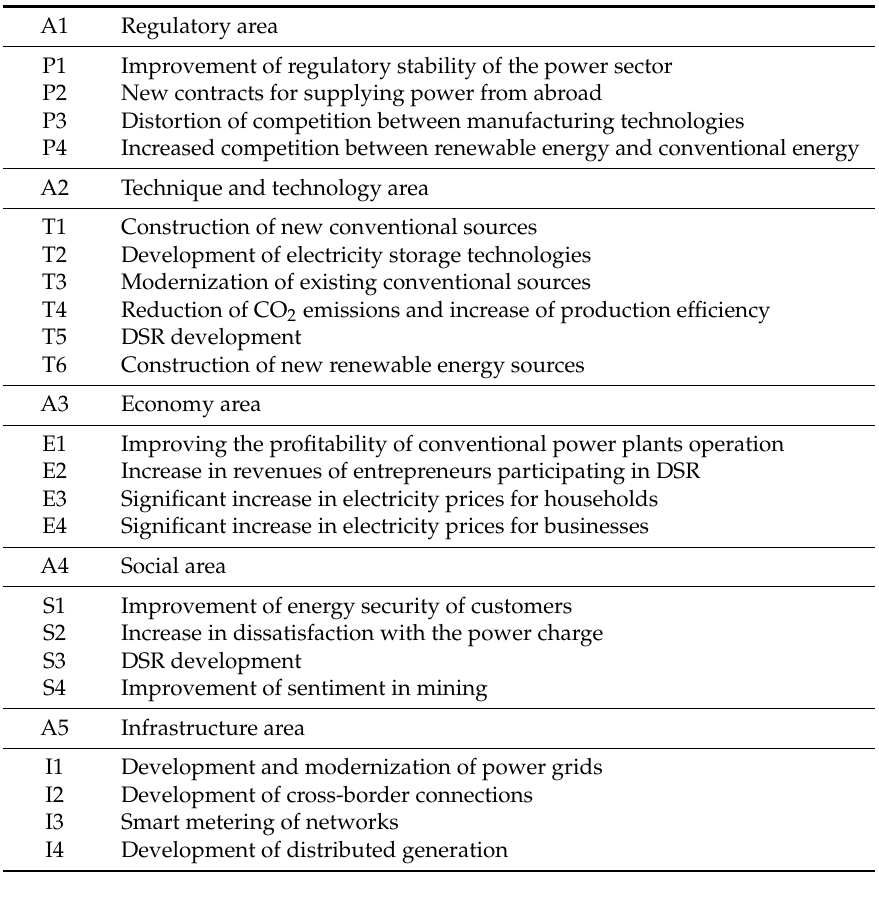
Table 1. Symbols used in the tests.